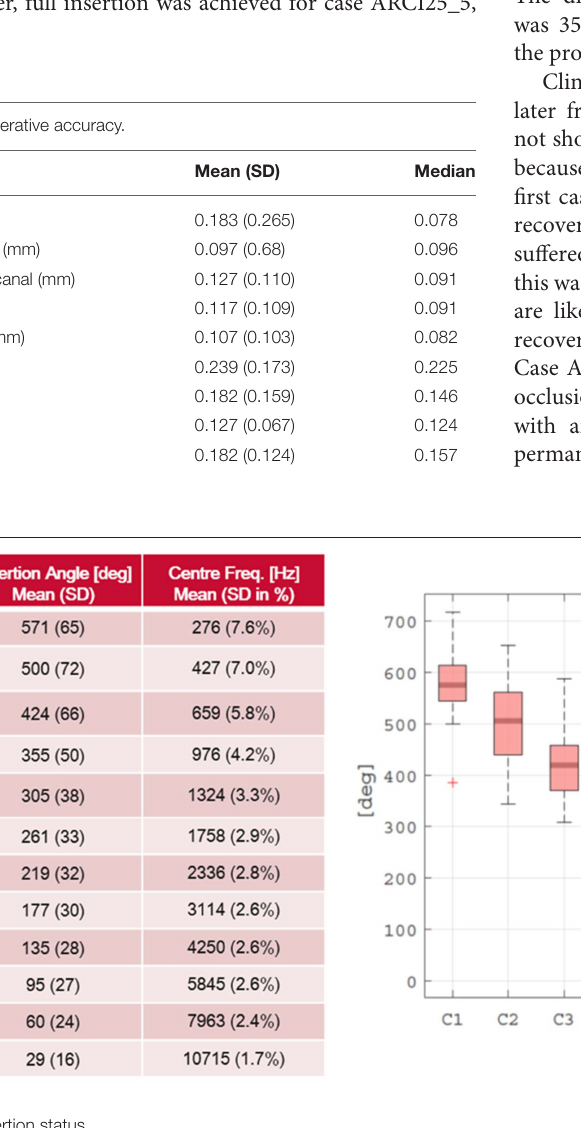
FIGURE 7 | Insertion